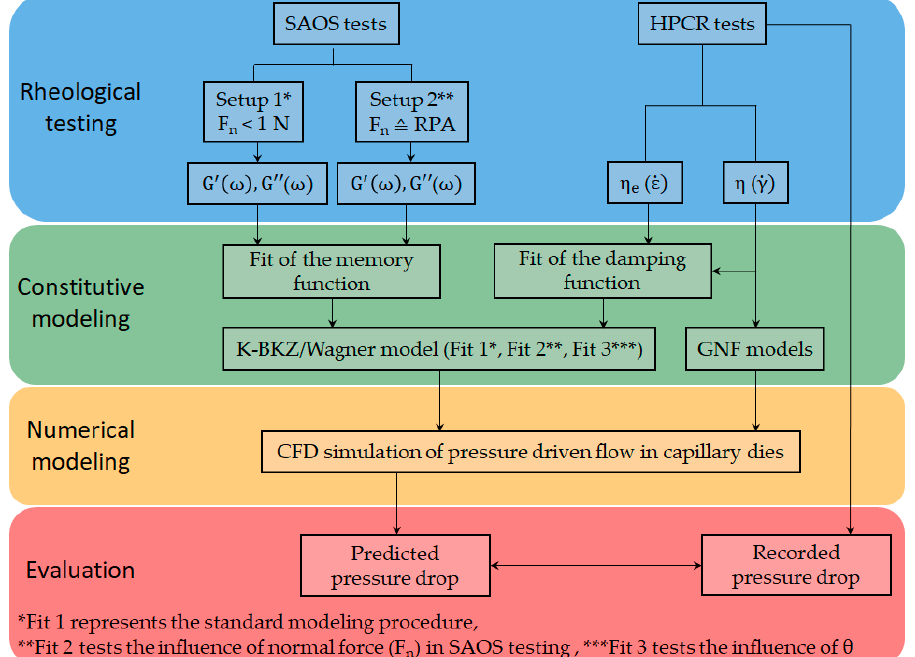
Figure 2. Flow chart displaying the research design of the present study. First, rheological tests are performed in the LVE (SAOS) and non-LVE (HPCR) de- formation range of gum NBR. The material properties obtained from these measure- ments are storage (G’) and loss (G’’) moduli, both in dependence of the angular fre- quency ( ω ) as well as steady-state shear ( η ) and uniaxial elongational ( η (cid:2915) ) viscosities, which are in dependence of the shear ( γ(cid:4662) ) and strain ( ε(cid:4662) ) rate, respectively. These material properties are used to determine the model parameters of the K-BKZ/Wagner, Cross (GNF), and power-law (GNF) models. Additionally, the influence of normal force ap- plied on the sample in SAOS testing as well as the influence of the model parameter θ (Equation (2)) is analyzed by performing in total three K-BKZ fits. Finally, CFD simula-